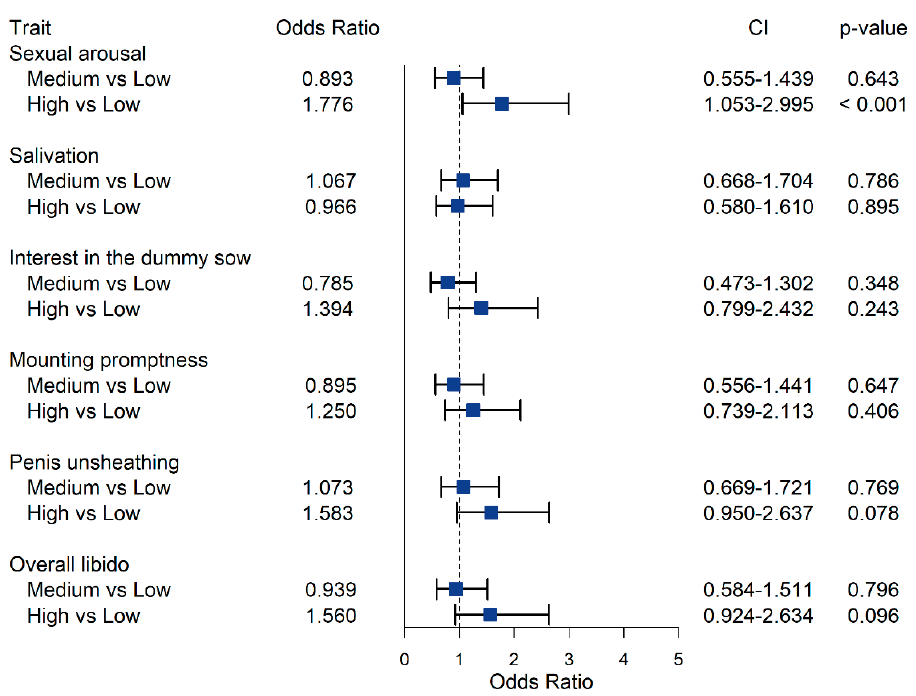
Figure 3. Odds ratio for the effect of average and high androstenone concentration in subcutaneous adipose tissue, compared to low androstenone concentration, on sexual behavior traits evaluated during the third training session. The dashed line corresponds to an odds ratio equal to 1.00.